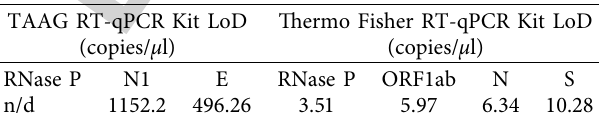
Table 1: Summary of limit of detection (Lod, viral copies/ µ l) for each probe of the analyzed RT-qPCR kits TAAG RT-qPCR Kit LoD Thermo Fisher RT-qPCR Kit LoD (copies/ μ l) (copies/ μ l) RNase